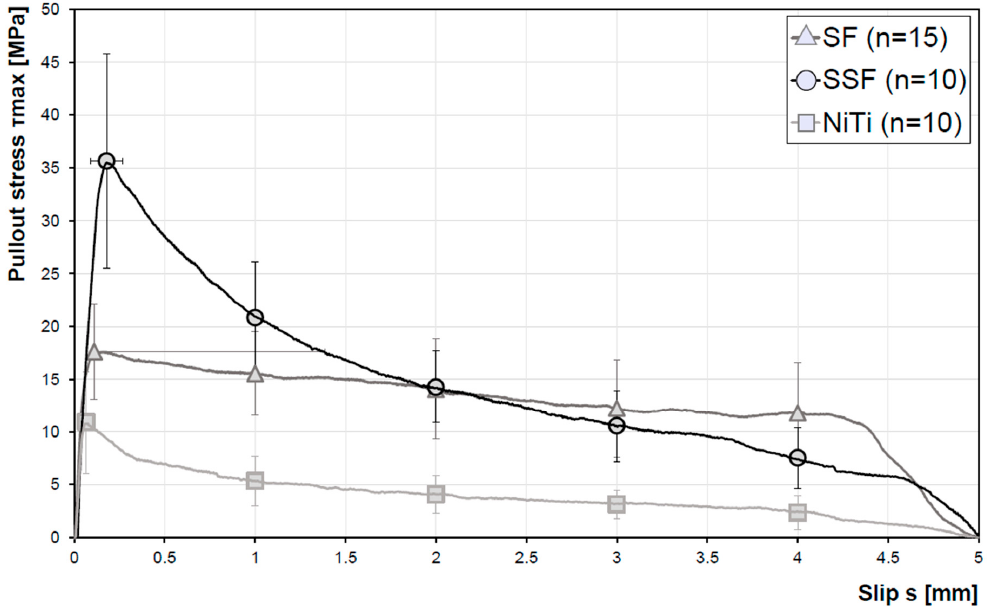
Figure 6. Figure 6. Average fibre pullout stress versus slip curves for the different fibre types without surface treatment.